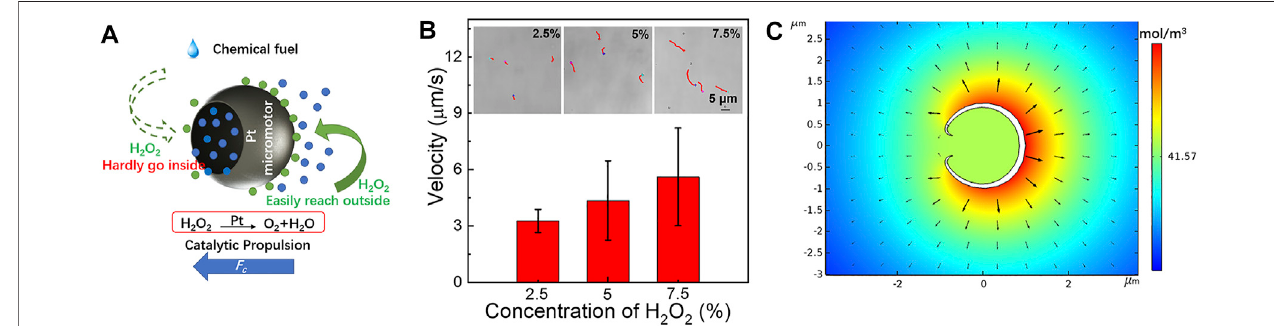
FIGURE3|(A) SchematicofthechemicalpropulsionsofthemicromotorfueledbyH 2 O 2 . (B) Thein fl uenceofthefuelconcentrationonthespeedofthemicromotor s. The insets are track-lines ofsuch motors fueledby thecorrespondingconcentrationofH 2 O 2 in3 s(taken from Supplementary VideoS1 ). (C) Distributionofoxygen around the Pt